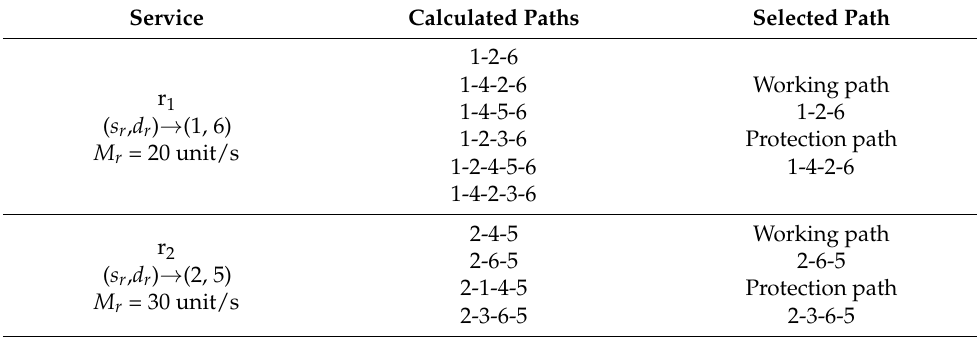
Table 2. The operation of the services in the